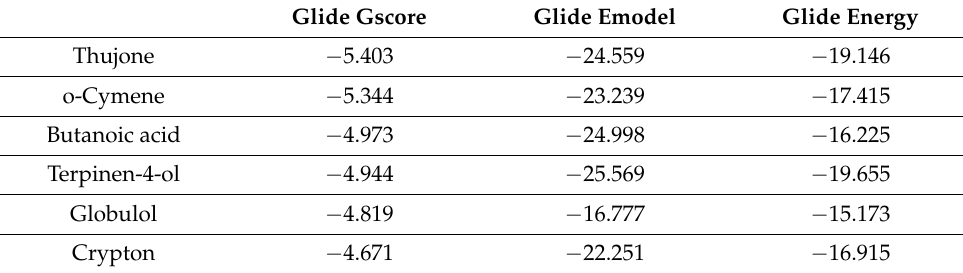
Table 5. Docking results of EOBD in the active site of NADPH (PDB: